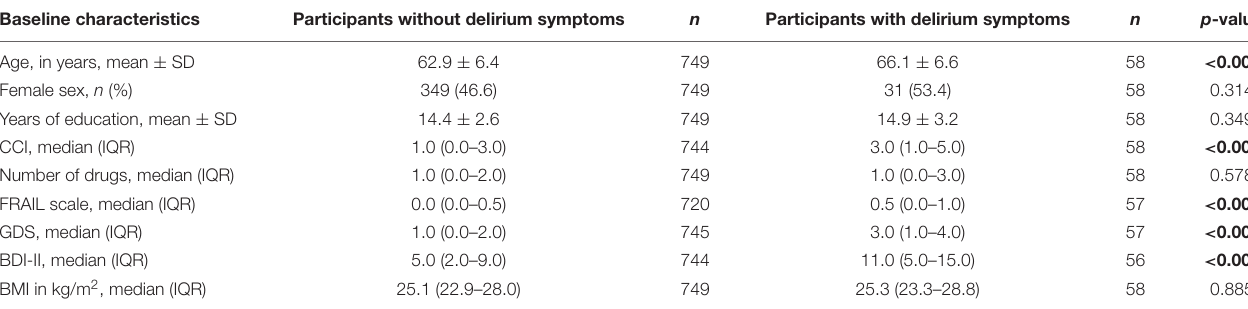
TABLE 1 | Baseline characteristics for participants with and without delirium symptoms. Baseline